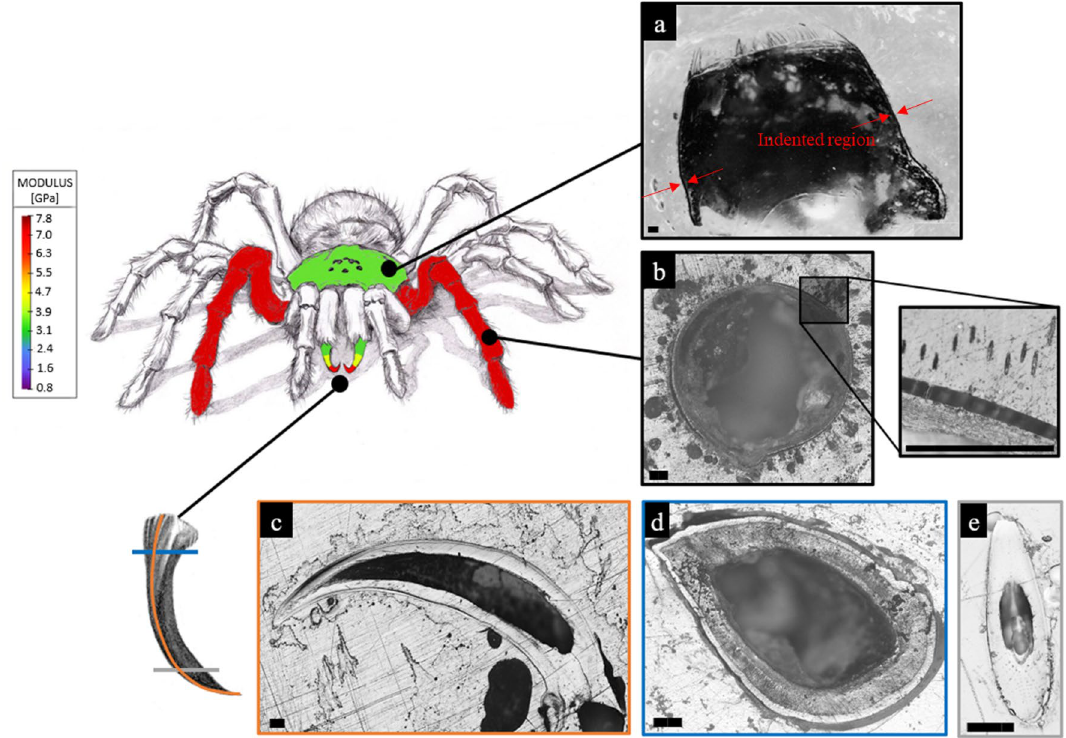
Figure 1. Representative drawing of the spider with the sections of interest. Coloured areas represent different results of the Young’s modulus measured by nanoindentation. ( a ) Section of the prosoma in the longitudinal direction (here the indented region is indicated). ( b ) Section of the leg in the transversal section with a detail of the hair section. ( c ) Section of the fang in the longitudinal direction. ( d ) Section of the fang in the transversal direction, on the base. ( e ) Section of the fang in the transversal direction, on the tip. The colour filling of the spider schematic is to be considered illustrative, as the exoskeleton is composed of many other parts, e.g. hairs, joints. Scale bars: 200 µm.